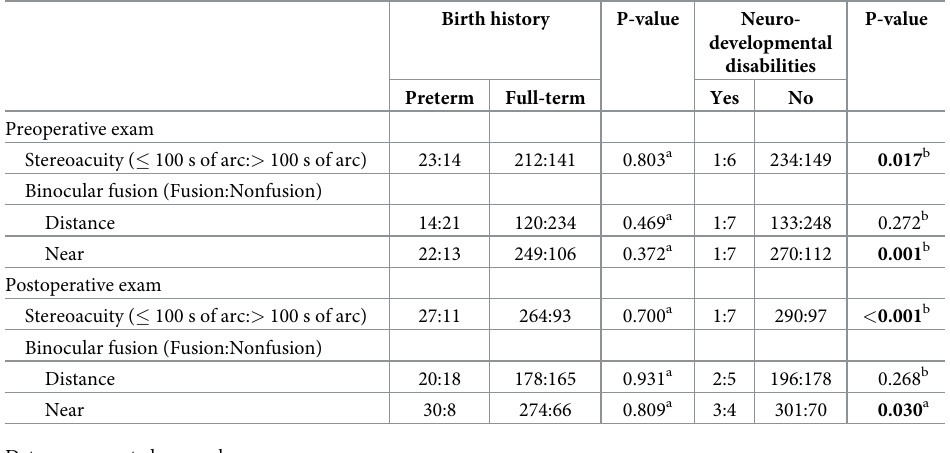
respectively). Survival curves showed significant differences in the overcorrection rate accord- ing to the presence of neurodevelopmental disabilities (p = 0.010) (Fig 2). Sensory fusion and stereoacuity Stereoacuity was measured in 390 patients (81%) during the preoperative examination and 395 patients (82%) during the postoperative examination. Worth 4-dot measurements were available from 378 and 390 patients (79% to 81%) during the pre- and postoperative examina- tions, respectively (Table 5). The most recent postoperative tests were performed at 20.1 ± 13.8 and 20.9 ± 14.8 months after surgery in pre- and full-term patients, respectively. Binocular fusion at distance and near, and stereoacuity showed no difference in pre- and postoperative examinations between the pre- and full-term groups (Table 5). However, pre- and postoperative stereoacuity was significantly poorer in patients with neurodevelopmental disabilities than in those without neurodevelopmental disabilities (p = 0.017 and < 0.001, respectively). Pre- and postoperative binocular fusion at near also showed lower fusion in patients with neurodevelopmental disabilities than in those without neurodevelopmental Table 5. Pre- and postoperative fusion and